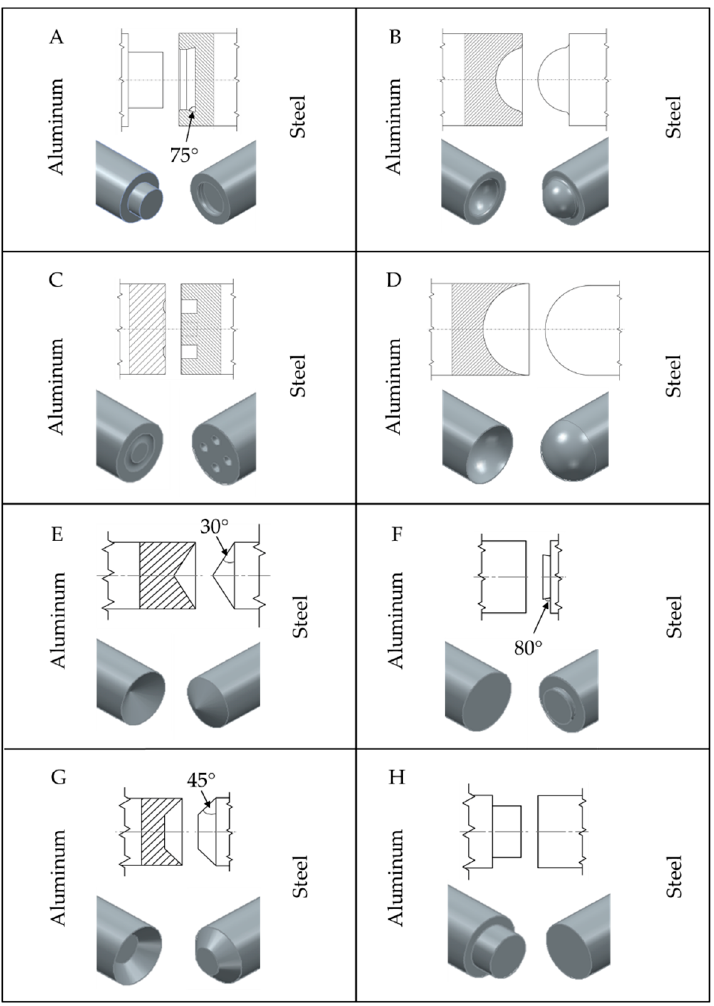
Figure 3. Geometries of friction surfaces ( A – H ), outer diameters of 40 mm. Table 3. Main parameters of the friction welding